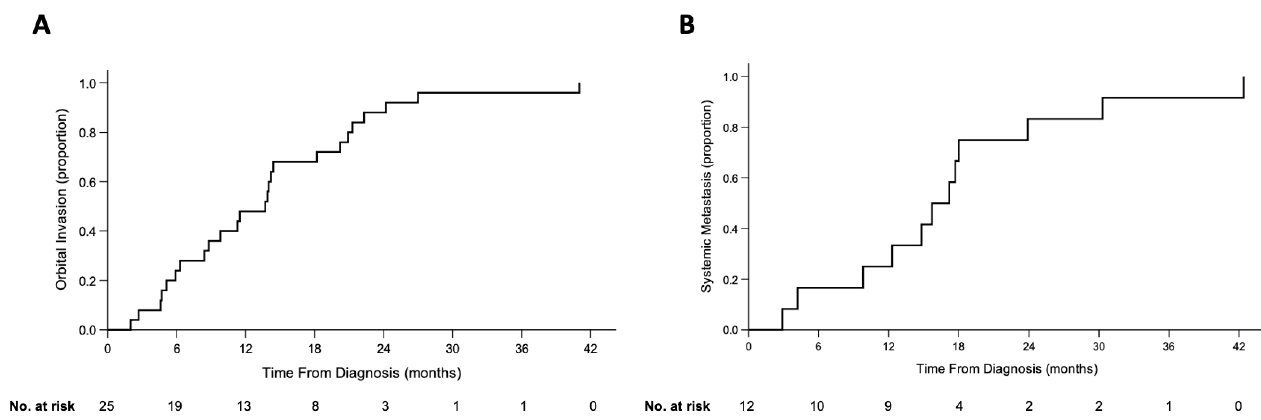
Figure 2. Kaplan-Meier curves of patients who received no treatment: ( A ) 25 patients with known dates of orbital extension, ( B ) 12 patients with known dates of systemic metastasis.